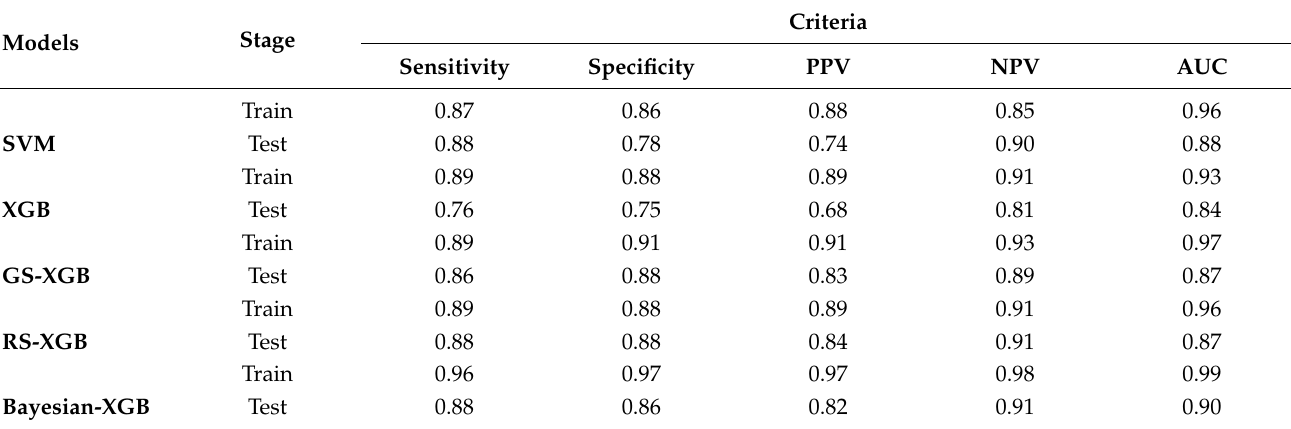
Table 3. Model evaluation during the training and testing